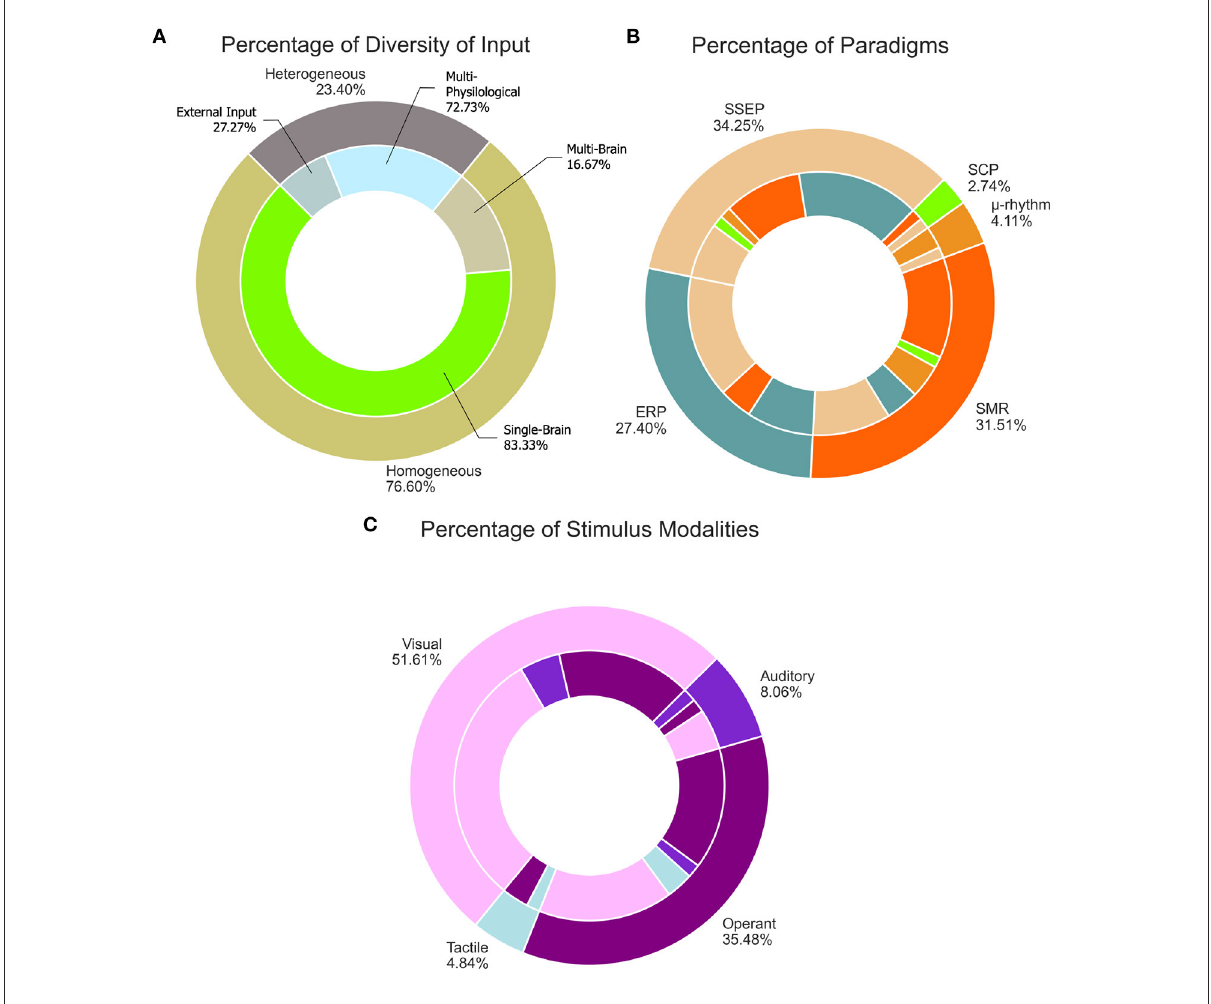
FIGURE8 Taxonomy distribution. (A) Percentage of diversity of input. (B) Percentage of paradigms. (C) Percentage of stimulus